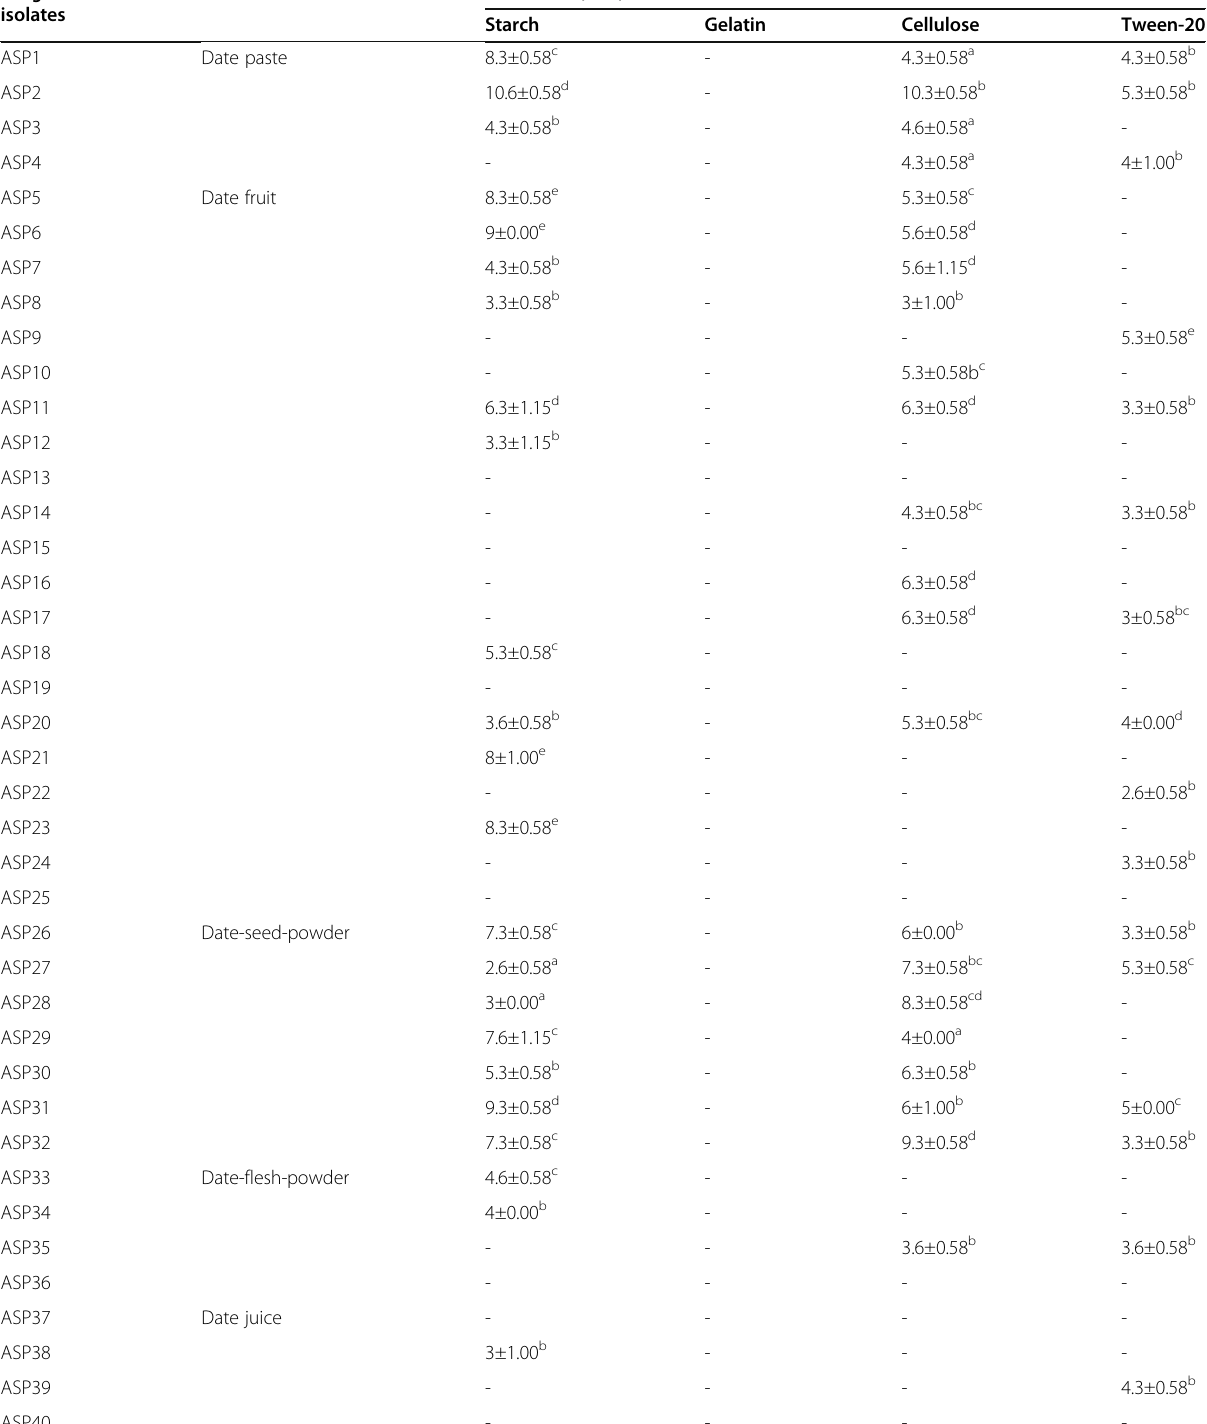
Table 1 Hydrolytic activity (mm) of Aspergillus niger isolates, obtained from different date